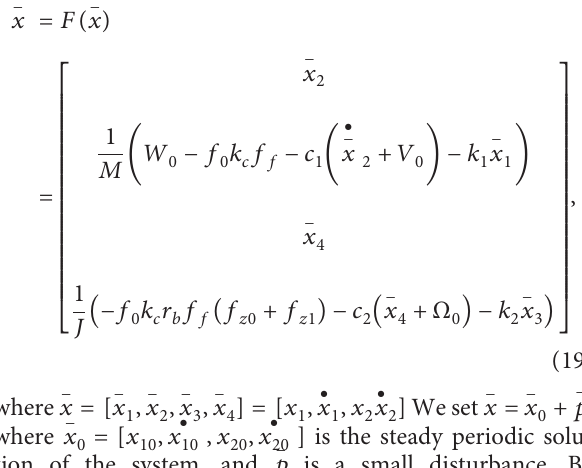
Figure 5 indicates the boundary curve of static bifur- cation, Hopf bifurcation, and period doubling bifurcation with different parameters. The red line is the Hopf bifur- cation boundary, the blue line is the static bifurcation boundary, and the green line is the period doubling bifur- cation